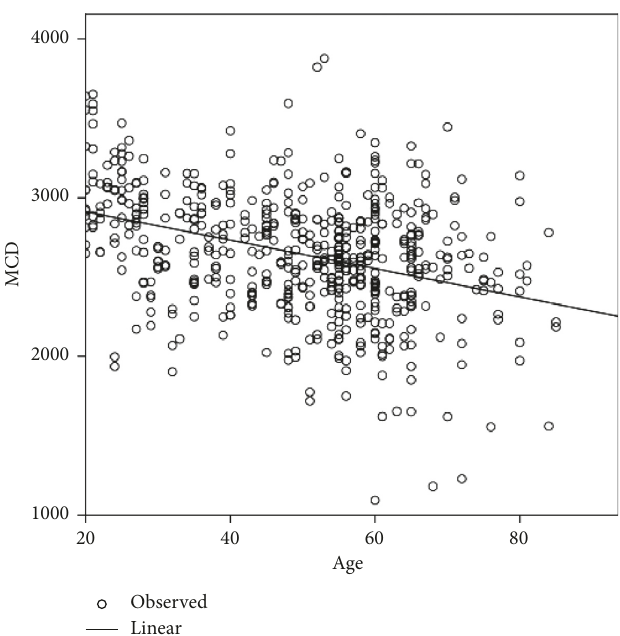
Figure 2: Relationship between the mean endothelial cell density (MCD) and age in Egyptian subjects with healthy eyes.